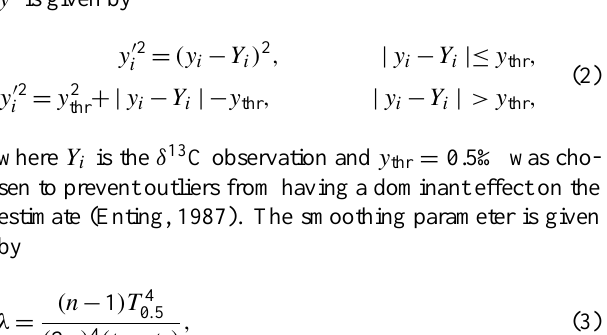
Fig. 5. Estimate of aliasing error, 2 σ ali , as a function of data resolution ∆ t (solid line). Dots are the root- mean-square of the residuals for each record, ¯ y 0 , as a function of mean data resolution, with a line of best fit, y 0 (dashed line). 2 σ ali is calculated using Eqn. (5). h record (note that t is defined positive towards the past),